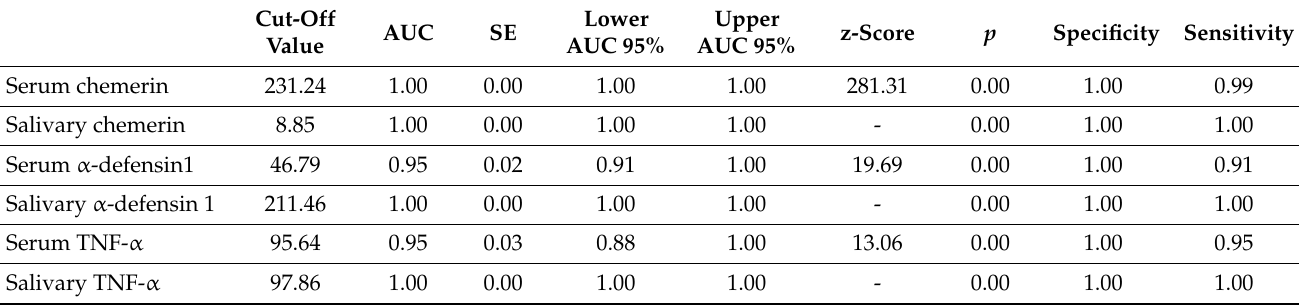
Table 3. ROC curve analysis for differentiation of patients with CRC and healthy subjects